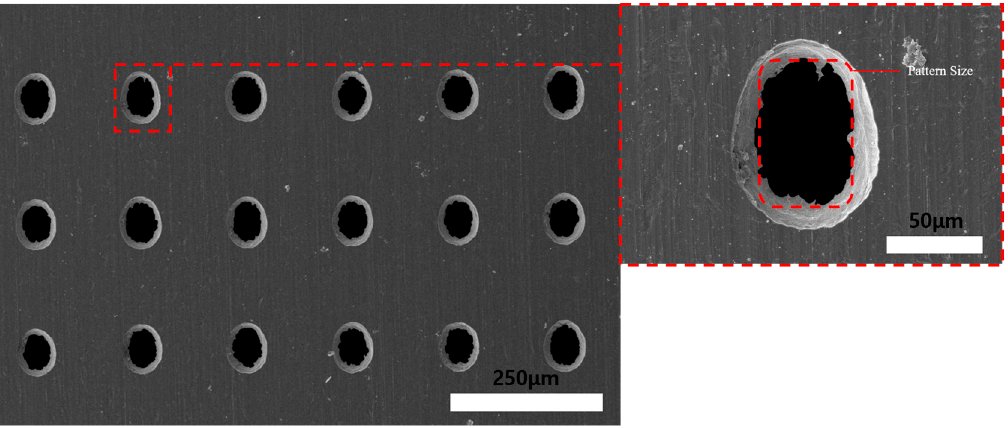
Figure 17. SEM images of 15 min electrochemical machined Invar thin film after wet etching (photoresist coating opposite face etching) for 5 min.